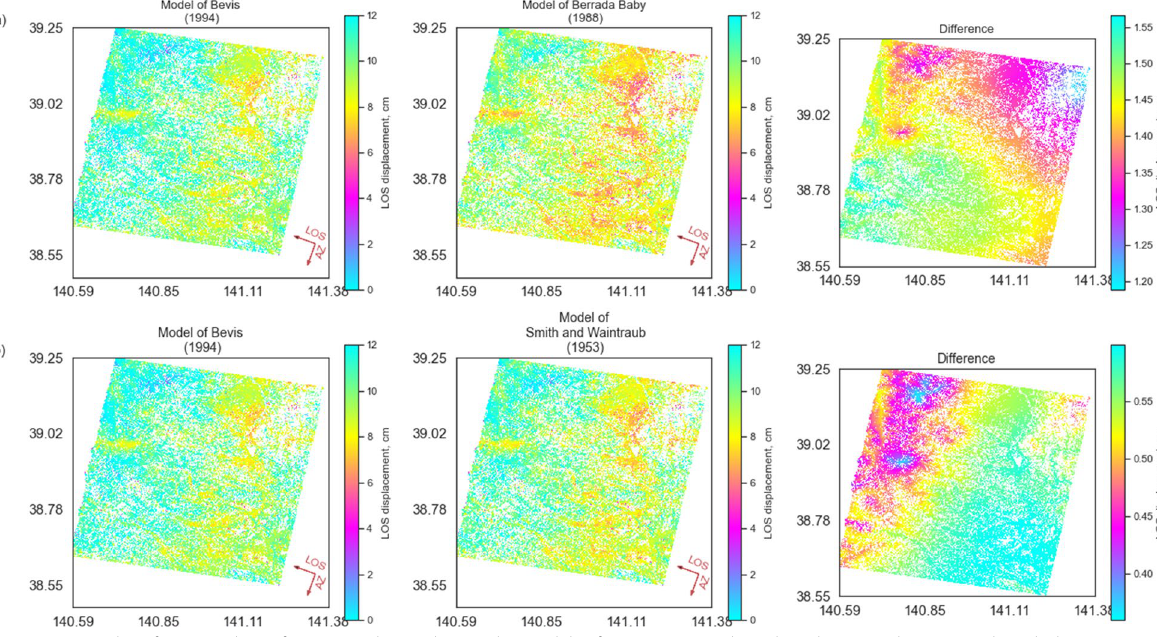
Fig. 6 a Examples of corrected interferograms obtained using the models of Bevis (1994) and Smith and Weintraub (1953) in the Tohoku region. b Examples of corrected interferograms obtained using the models of Bevis (1994) and Berrada-Baby et al. (1988) in the Tohoku region. The acquisition dates are identical to those shown in Fig.